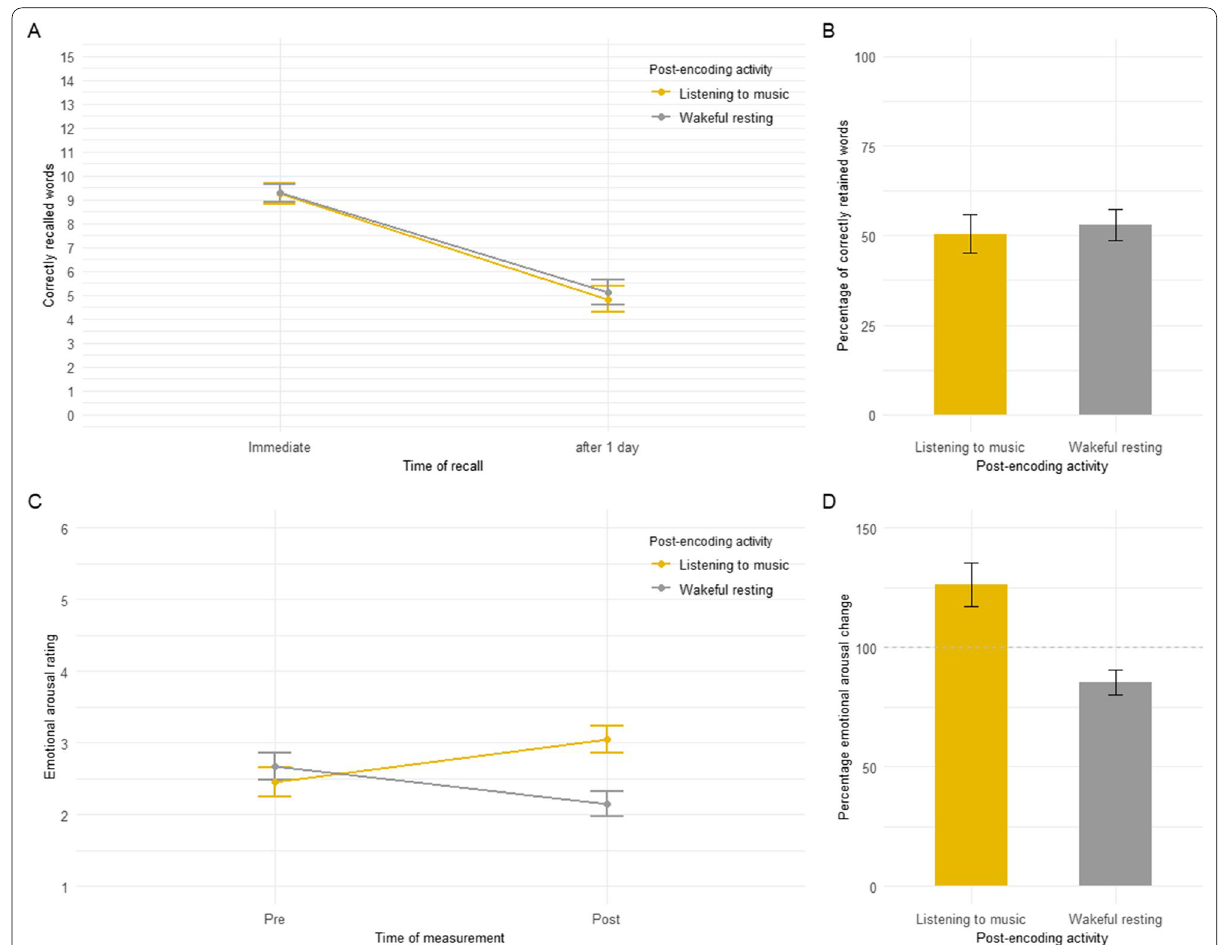
Fig. 1 A Mean number of words correctly recalled (out of 15 per word list) as a function of the post-encoding activity (wakeful resting [grey] vs. listening to music [yellow]) and time of recall (immediate vs. after 1 day). B Mean retention scores in percent as a function of post-encoding activity (wakeful resting [grey] vs. listening to music [yellow]). Retention scores were calculated by dividing the number of correctly recalled words in Session 2 by the number of correctly recalled words in Session 1 and multiplying the quotient by 100. C Mean emotional arousal ratings as a function of the post-encoding activity (wakeful resting [grey] vs. listening to music [yellow]) and time of measurement (before learning the word list [pre] vs. after the post-encoding activity [post]). D Percentage emotional arousal change scores as a function of post-encoding activity (wakeful resting [grey] vs. listening to music [yellow]). Percentage emotional arousal change scores were calculated by dividing participant’s emotional arousal rating before encoding a word list divided by the emotional arousal rating after the respective post-encoding activity (wakeful resting vs. listening to music) multiplied by 100. Dashed helpline: 100% indicates no change in the mean pre- to post emotional arousal ratings. Error bars represent standard errors of the